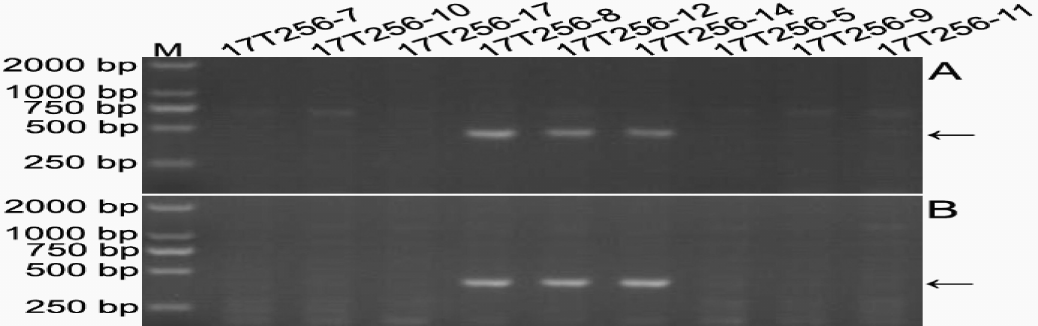
Figure 5. Representative results of locating 6RL Ku minichromosome-specific markers on 6RL Kumi119 segment. ( A ) Products amplified by marker 6RL-M11. ( B ) Products amplified by marker 6RL-M102. M, DNA marker. Arrows indicate 6RL Kumi119 -specific